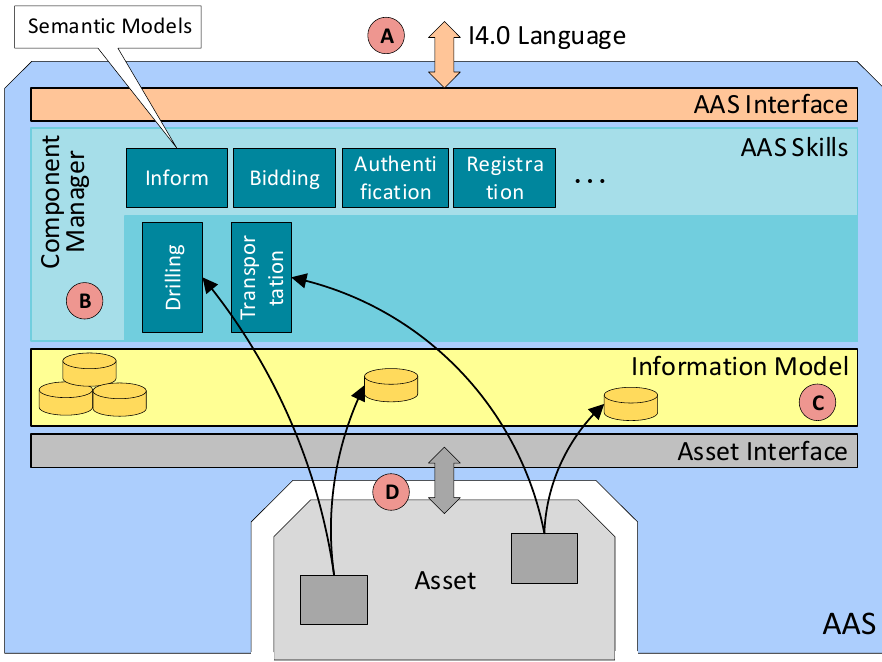
Figure 10. A block diagram of an AAS.